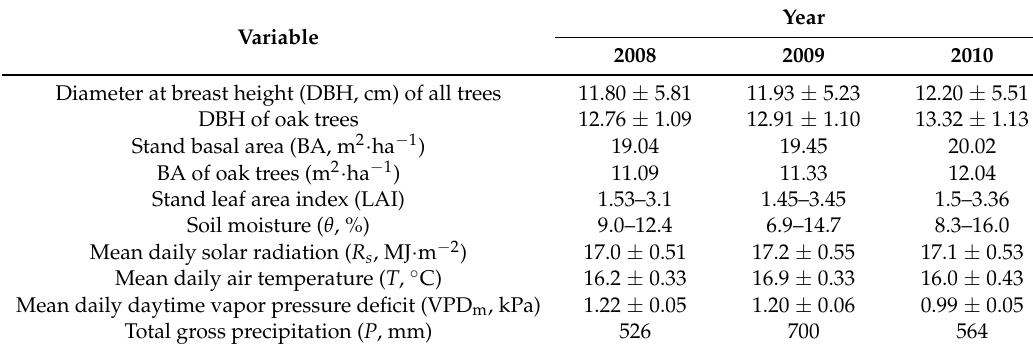
Table 1. Summary of climatology and stand characteristics over the three